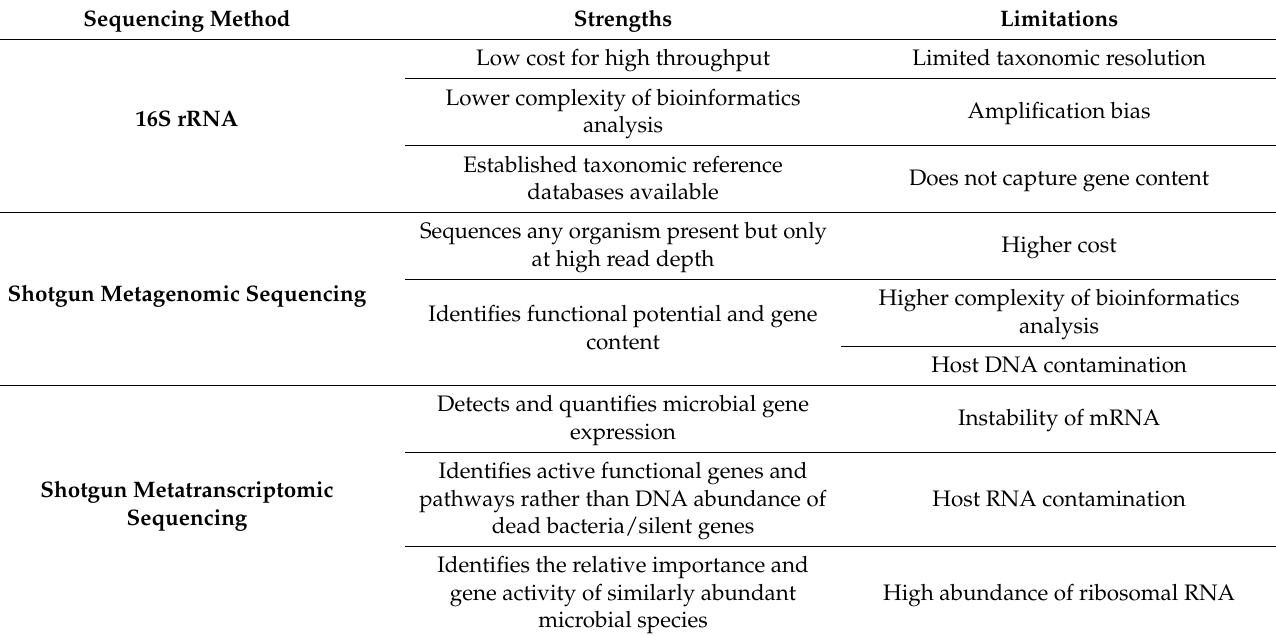
Table 2. Overview of strengths and limitations of the most common methods used in sequencing-based microbiome studies. Sequencing